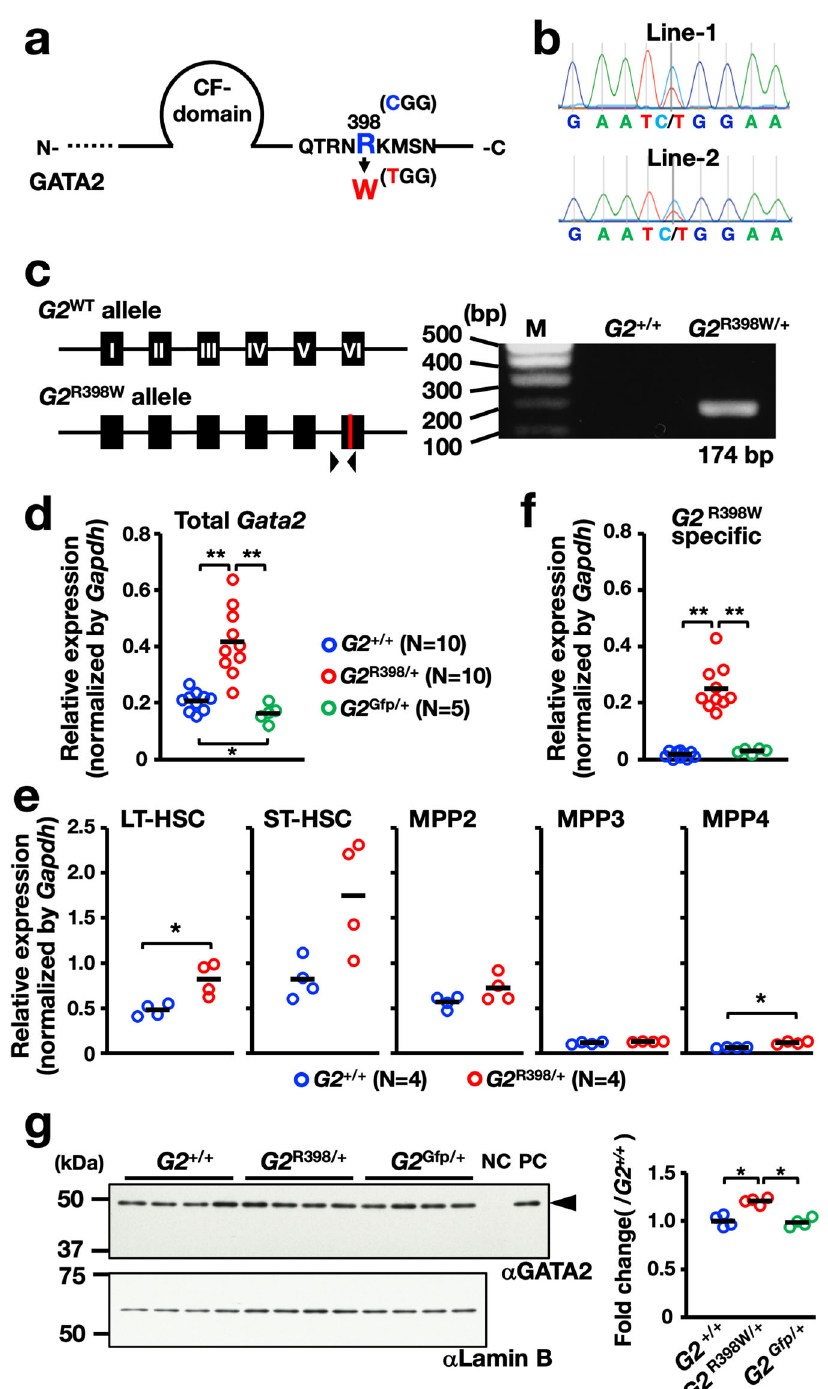
Fig. 1 Generation of genome-edited mice carrying the G2 R398W mutation. a Schematic illustration of genome editing patterns and locations. b Genomic DNA sequences of two independent founder mice at the targeted region of the Gata2 gene. The signal peaks of the original cytosine (blue) and substituting thymine (red) overlap at position c.1192. c PCR-based genotyping strategy of the G2 R398W allele containing the substituted nucleotide. c.1192C>T in the 6th exon is indicated as a red line. Positions recognized by the forward and reverse primers are indicated as arrowheads. d , e Dot plots and mean values for Gata2 transcripts expressed in LSK cells ( d ) and in subpopulations of LSK cells ( e ). A primer set detecting transcripts originating from both intact and mutated alleles was used. f Dot plots and mean values for mutated Gata2 transcripts expressed in LSK cells, which were detected using a mutated allele- speci fi c primer set. Number of mice are indicated in parentheses. ** p < 0.01. g Immunoblot analysis using nuclear extracts from bone marrow cells. Four independent mice of each genotype were used. Cell extracts from original and murine GATA2-expressing HEK293T cells were used as negative (NC) and positive (PC) controls, respectively. The levels of GATA2 were evaluated by comparing the signal intensity with that of Lamin B. The average value of GATA2 in G2 + / + mice was set to 1.0. The average and individual relative values of GATA2 in individuals are shown in the right panel. * p < 0.05.